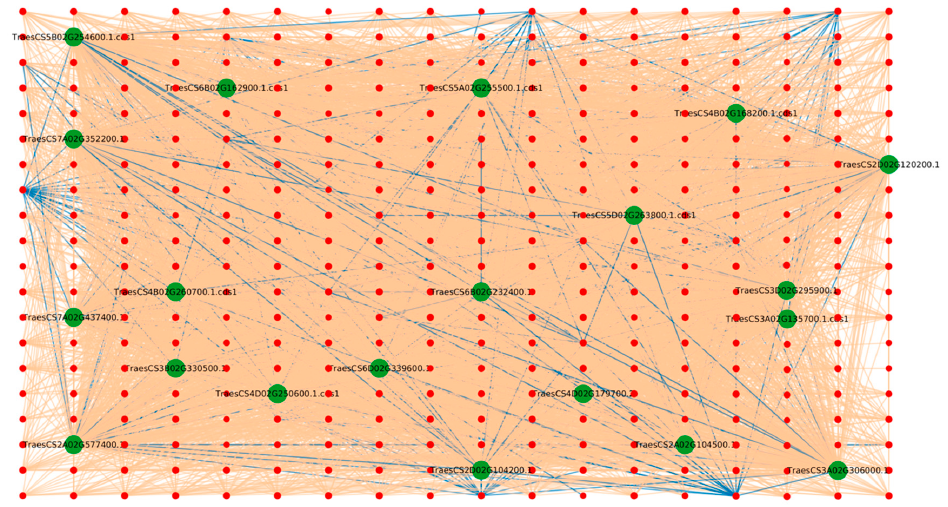
Figure 1. Protein–protein interaction network for the top 20 host protein hubs. Green nodes represent host proteins and red nodes are pathogen proteins. Orange edges depict the interactions from the interolog-based approach, while blue edges belong to the domain-based approach.